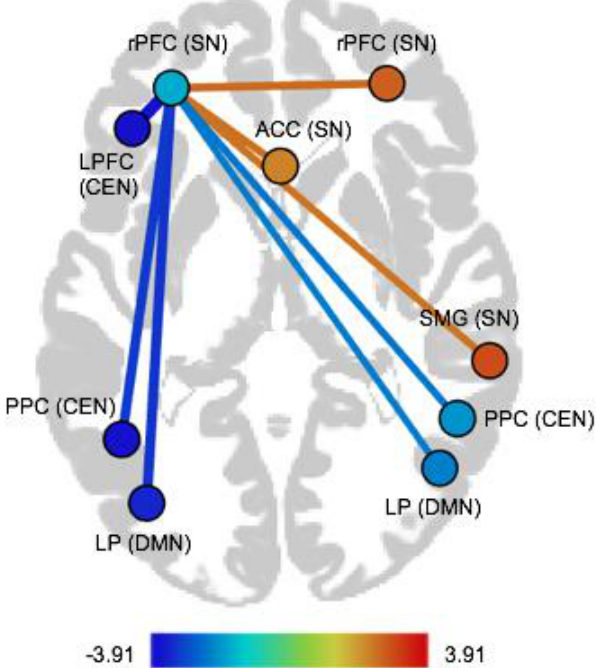
Figure 1. Illustration of ROI-to-ROI FC associated with the BDI-II score. rPFC = rostral prefrontal cortex, ACC = anterior cingulate cortex, LPFC = lateral prefrontal cortex, SMG = supramarginal gyrus, PPC = posterior parietal cortex, LP = lateral parietal, SN = salience network, CEN = central executive network, DMN = default mode network.